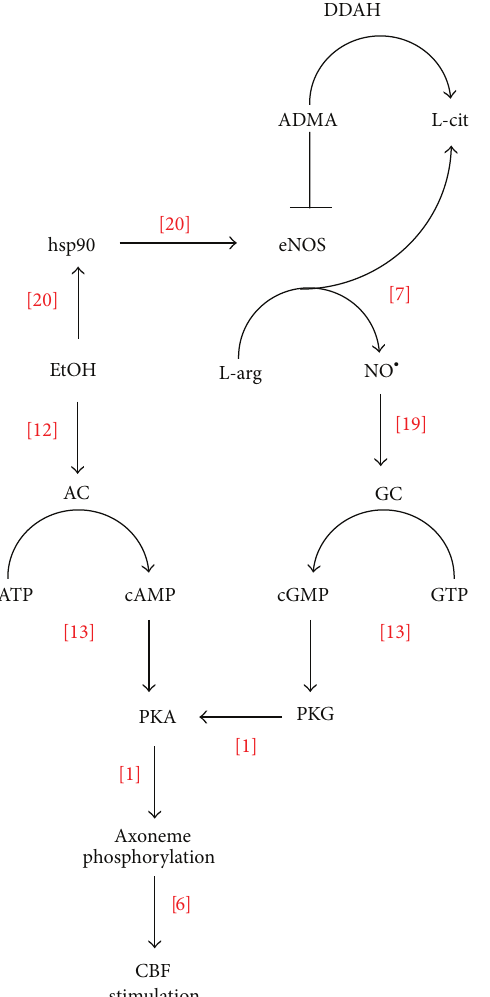
Figure 7: Proposed model of ADMA action on alcohol-stimulated cilia beating. Alcohol (EtOH) rapidly and transiently stimulates cilia beat frequency (CBF) by both activating the alcohol-sensitive adenylyl cyclase isoform 7 (AC) and increasing the phosphorylation of heat shock protein 90 (hsp90) leading to the increased binding of hsp90 and the activation of nitric oxide synthase (eNOS). Nitric oxide (NO ∙ ) activates soluble guanylyl cyclase (GC) leading to a cGMP-dependent protein kinase (PKG) activation required for alcohol-induced activation of cAMP-dependent protein kinase (PKA). Asymmetric dimethylarginine (ADMA) functions to neg- atively regulate alcohol stimulation of eNOS, except under the conditions of elevated dimethylarginine dimethylaminohydrolase (DDAH) whereby ADMA is converted to L-citrulline